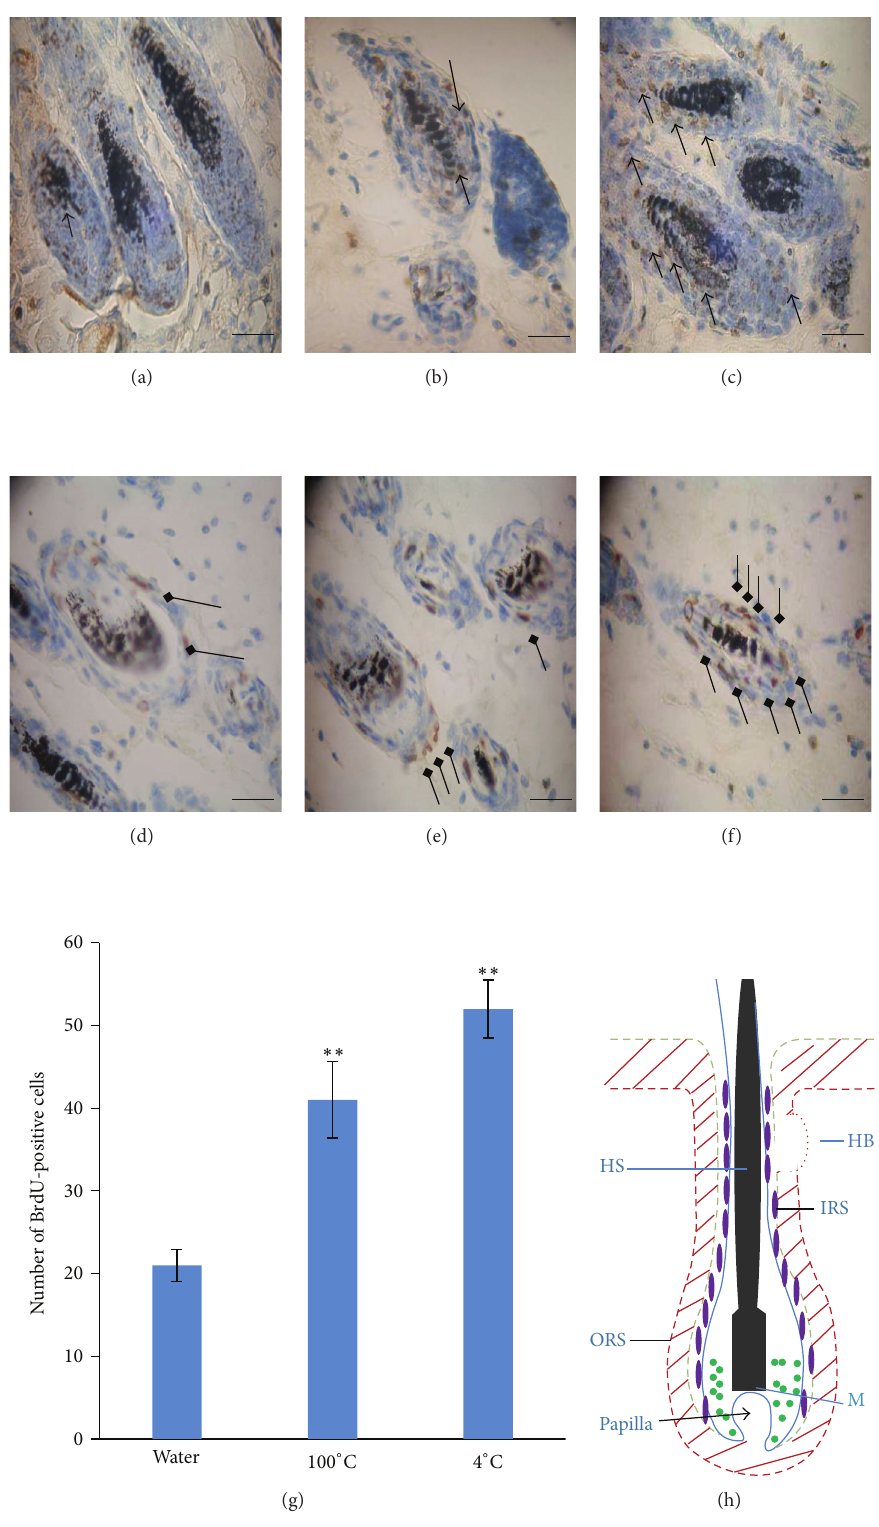
Figure 2: Immunohistochemical analysis of BrdU retention in matrix and outer root sheath region. BrdU staining in hair follicles from 7- week-old C57BL/6 mice treated with water, 100 ∘ C and 4 ∘ C AAE at 100x magnification. ((a)–(c)) Vertical section BrdU incorporation cell in matrix part in the water, 100 ∘ C AAE and 4 ∘ C AAE group (open arrows indicated BrdU-positive cells). ((d)–(f)) Transverse sections BrdU incorporation cell in outer root sheath part in the water, 100 ∘ C AAE and 4 ∘ C AAE groups (diamond arrows indicated BrdU-positive cells). (g) Number of BrdU-positive cell in a fixed area with a width of 300 𝜇 m. (h) Schematic diagram of a hair follicle showing key components. Abbreviations: HS: hair shaft; M: hair matrix; IRS: inner root sheath; ORS: outer root sheath. Scale bars are 100 𝜇